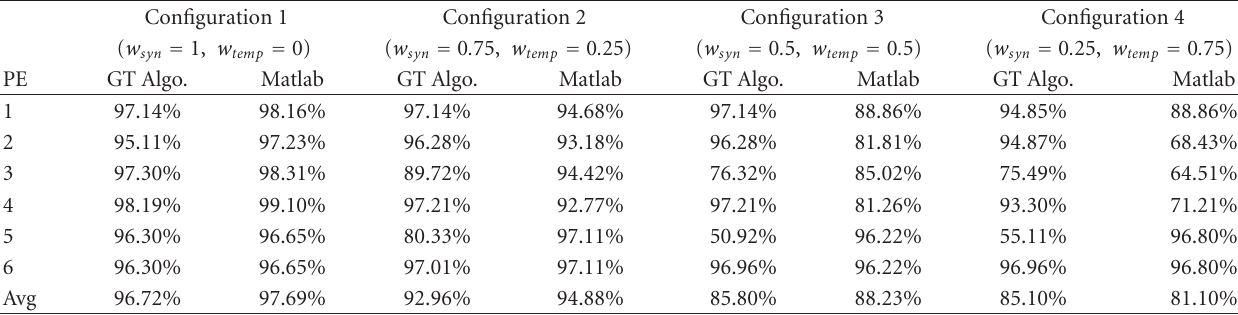
Table 4: Test case synchronization